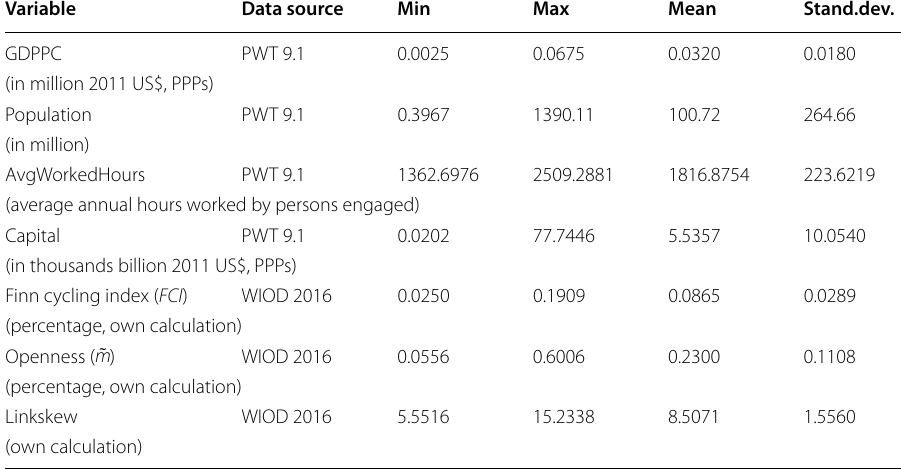
Table 2 The descriptives statistics of